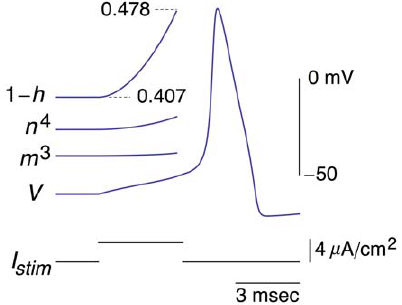
Figure 7. Ionic mechanism underlying response of the Hodgkin and Huxley model to a rectangular depolarizing current pulse. The 1 2 h , n 4 , and m 3 results correspond to the changes in these parameters from the beginning of the stimulus ( I stim ) until a point near threshold similar to that of the optimal stimulus in Figures 2 and 3. The scales for these results are the same as in Figure 3. Note in particular changes that occur in both n 4 and 1 2 h , in contrast the results in Figure 3, as well as the significantly larger change in 1 2 h relative to the results in Figures 2 and 3.